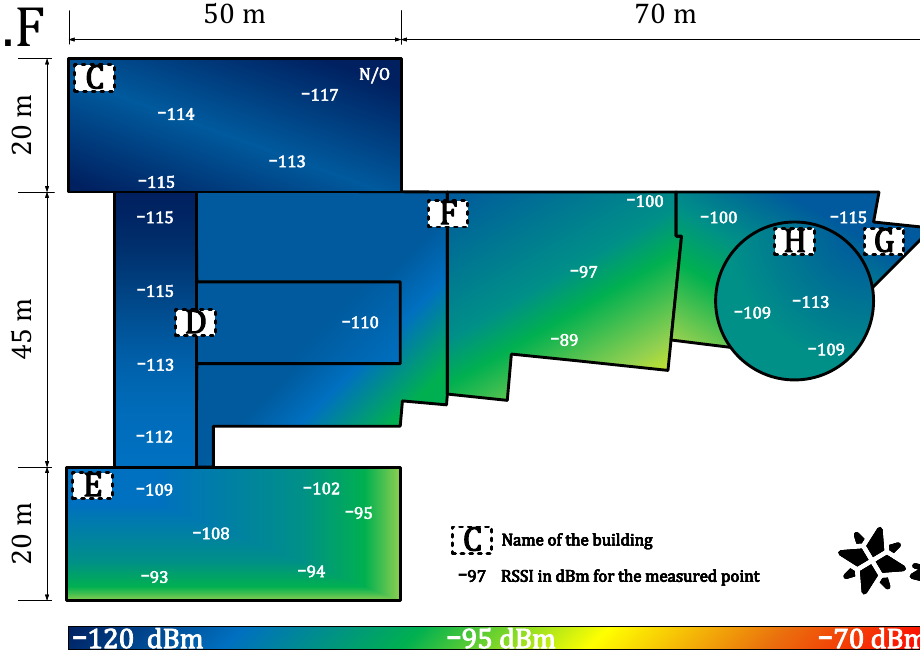
Figure 13. Private network coverage and signal propagation on the first